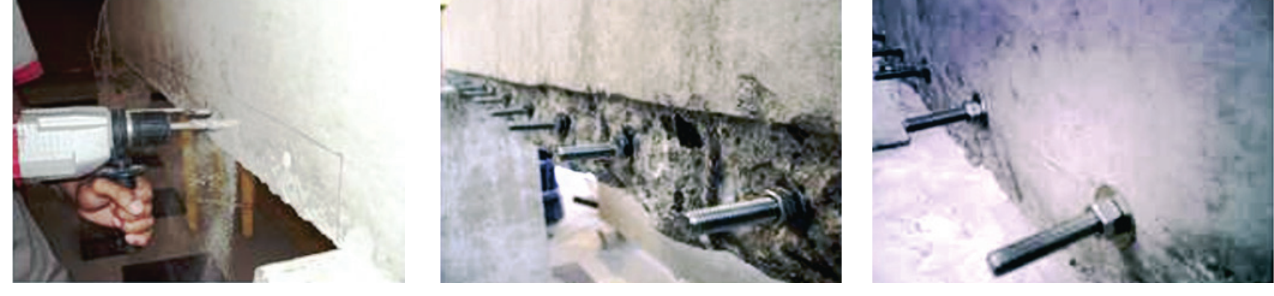
Expansion bolts